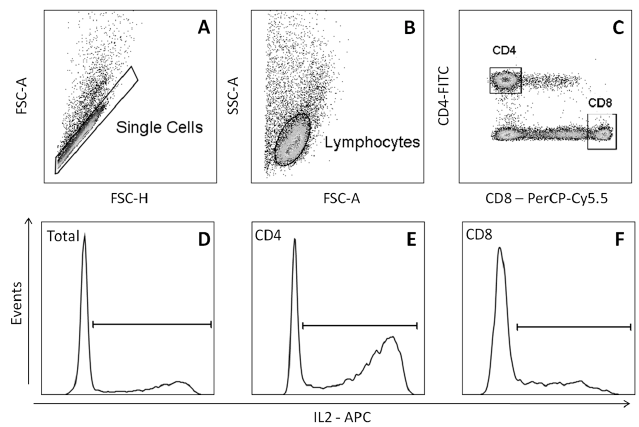
Figure 6. Computational strategy used to evaluate the percentage of positivity of cytokines on lymphocytes. Dot plot graphs were used sequentially for the selection of single cells ( A ); total lymphocytes ( B ); and CD4 + or CD8 + lymphocytes ( C ). In the sequence, histograms were used in the analysis of the percentage of cytokine-stained total lymphocytes ( D ), CD4 + lymphocytes ( E ) and CD8 + lymphocytes ( F